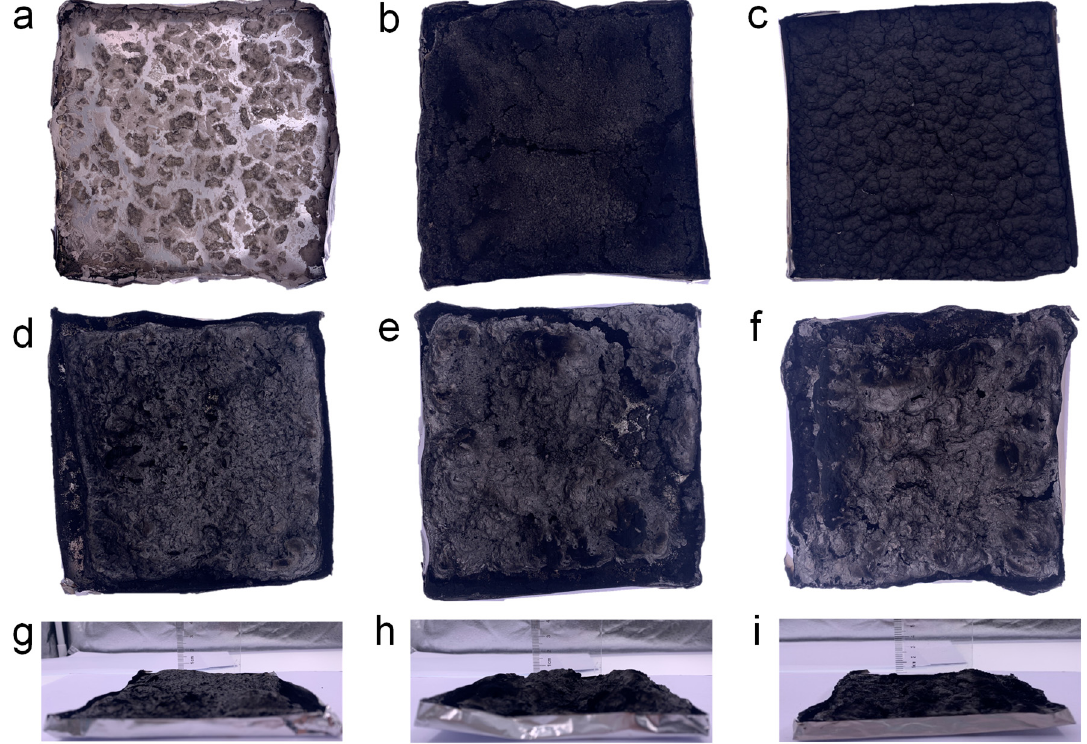
Figure 3. Digital photographs of ( a ) PEG/WF, ( b ) PEG/WF/10.0APP, ( c ) PEG/WF/10.0OMMT, ( d , g )